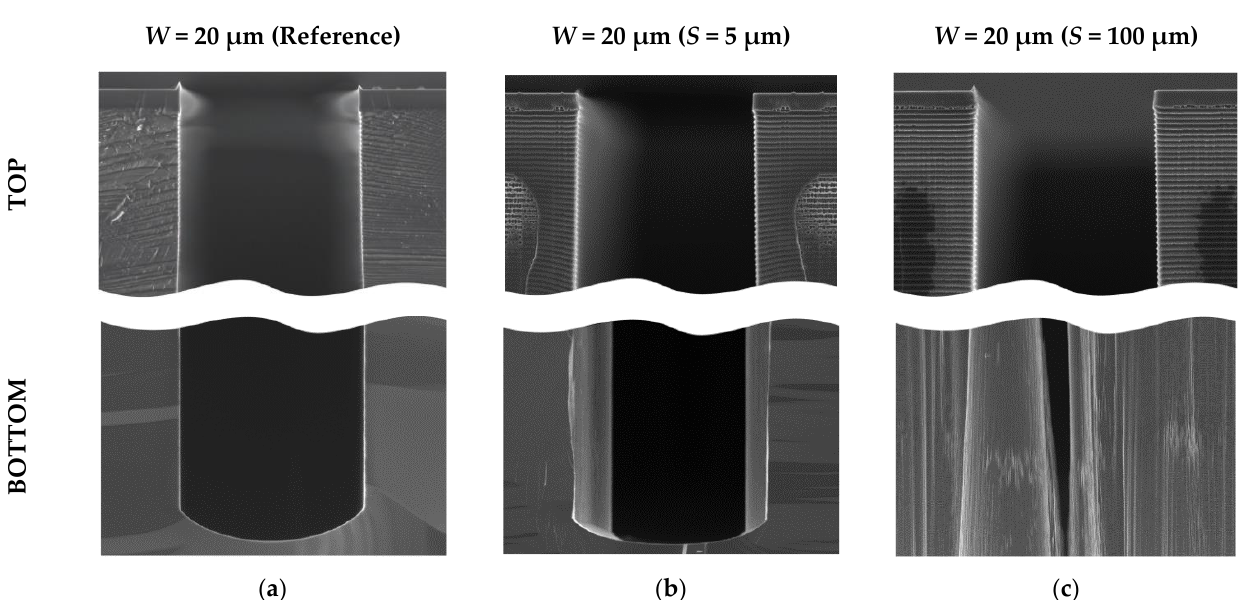
Figure 12. Twenty µ m wide target lines profiles comparison for different cleaving lines: ( a ) Dashed auxiliary line (reference); ( b ) 5 µ m wide transverse crossing auxiliary lines ( S = 5 µ m); ( c ) 100 µ m wide transverse crossing auxiliary lines ( S = 100 µ m).